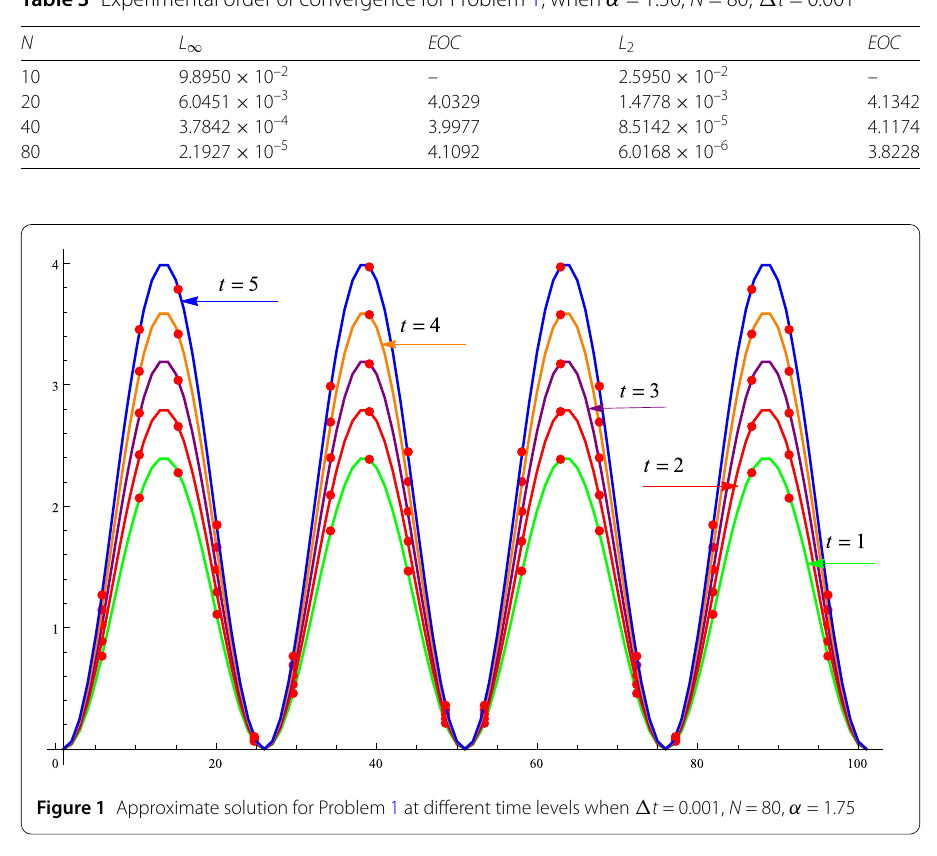
in [1]. In Table 2, the error norms L ∞ and L 2 are listed at t = 0.25,0.5,1 using different